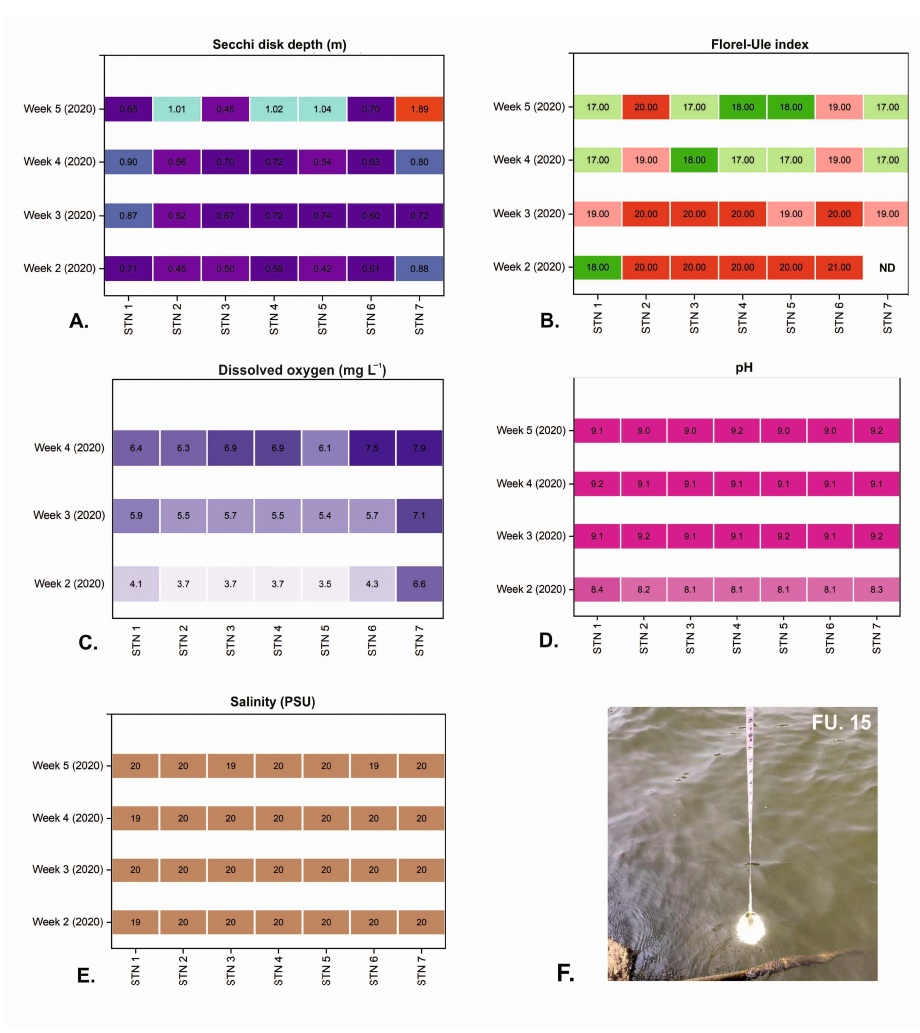
Figure 2. Variation in ( A ) Secchi depth (m), ( B ) water colour (Forel-Ule index), ( C ) DO (mg L − 1 ), ( D ) pH, and ( E ) salinity (psu) values at the 7 stations post demolition. ( F ) shows a sample photograph taken by citizen scientists of the water while operating the 3DMSD. ND—Not